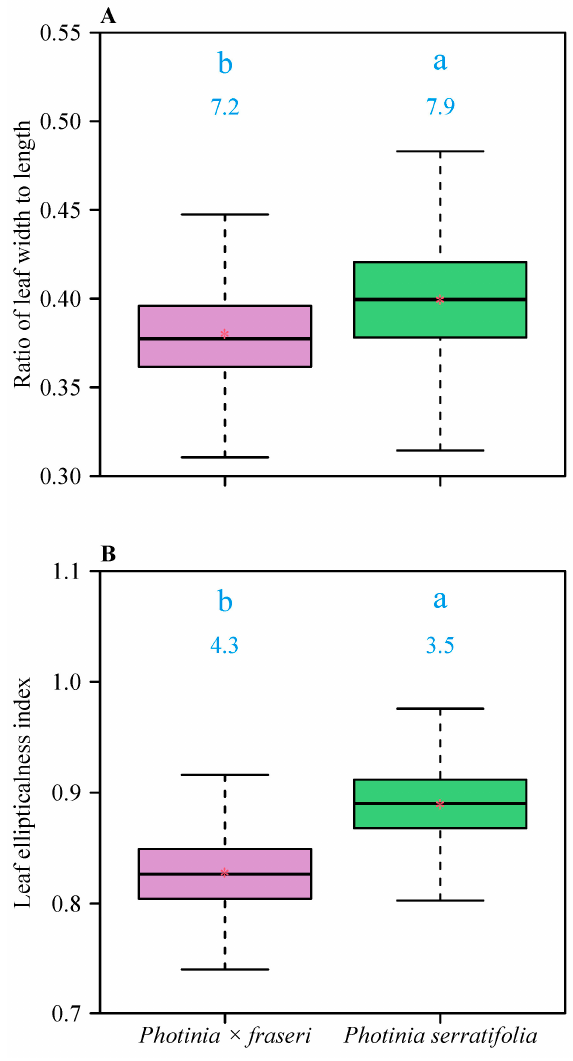
Figure 3. Comparison of leaf shape between the two Photinia taxa for the pooled data. ( A ) Ratio of leaf width to length; ( B ) Leaf ellipticalness index. In each panel, the letters on the whiskers show differences between the two taxa (i.e., taxa with different letters are significantly different at the α = 0.05 significance level using Tukey’s HSD); the values at the top of whiskers represent the coefficients of variation (%) for each taxon; the horizontal solid line represents the median; and the red asterisk represents the mean. The whiskers extend to the most extreme data point, which is no more than 1.5 times the interquartile range from the box. The difference in mean leaf W/L ratios is equal to 0.0193 with HSD = 0.0017, and the corresponding 95% Tukey’s test confidence interval is 0.0176, 0.0210, which does not include 0, indicating a significant difference; the difference in mean leaf ellipticalness indices is equal to 0.0617 with HSD = 0.0019, and the corresponding 95% Tukey’s test confidence interval is 0.0598, 0.0636, which also does not include 0, indicating a significant difference. There were significant differences in leaf shape (measured as either the W/L ratio or the EI) among the different months of collecting (Figure 4). Three of the four slopes of the linear model of leaf shape vs. month were statistically significant (with three p values < 0.05) with the exception of the EIs of P. serratifolia . However, the four coefficients of determination (i.e., r 2 values) were all less than 0.06, i.e., a very weak linear relationship was observed between leaf shape and sampling month. Thus, there is no robust evidence for a monotonic increase or decrease in leaf shape across leaf ages. The linear and quadratic coefficients in the parabolic model were statistically significant ( p values < 0.05) for the leaf